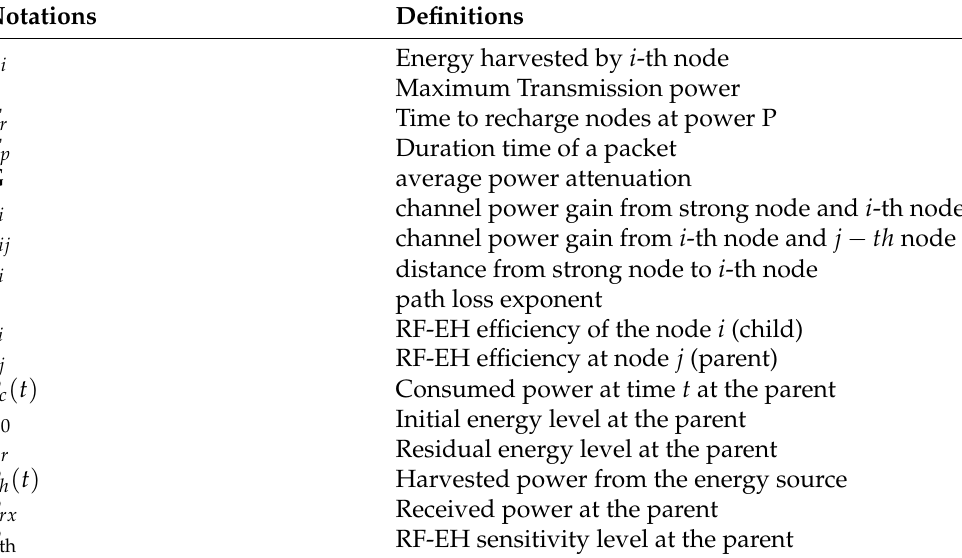
Table 1. Notations and